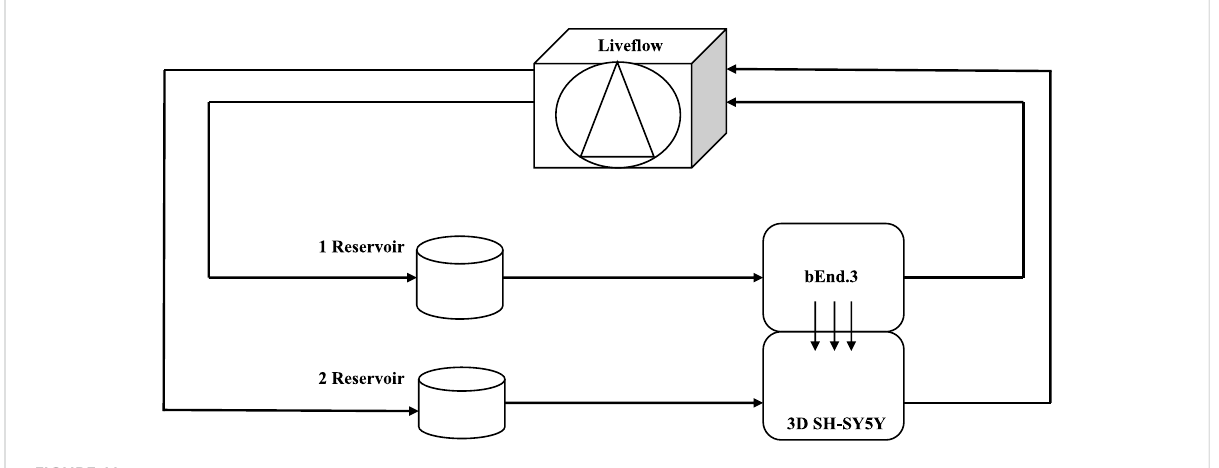
FIGURE 11 Schematic view of a dynamic bioreactor “ Live Box 2 (LB2) ” is composed by an upper chamber connected to a medium reservoir and to a Live fl ow pump (250 μ L/min) and a lower chamber connected to a medium reservoir and to a Live fl ow pump (250 μ L/min). In the upper chamber, bEnd.3 cells are seeded on the porous membrane, and there are neuroblastoma cells in the lower chamber enriched with neural portion (3D SH- SY5Y).